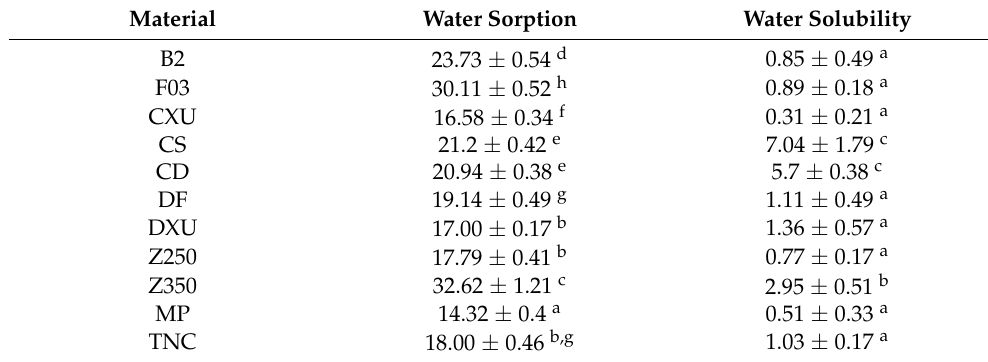
Table 4. Means and SD of water sorption and solubility ( µ g/mm 3 ) for the tested composite resins.